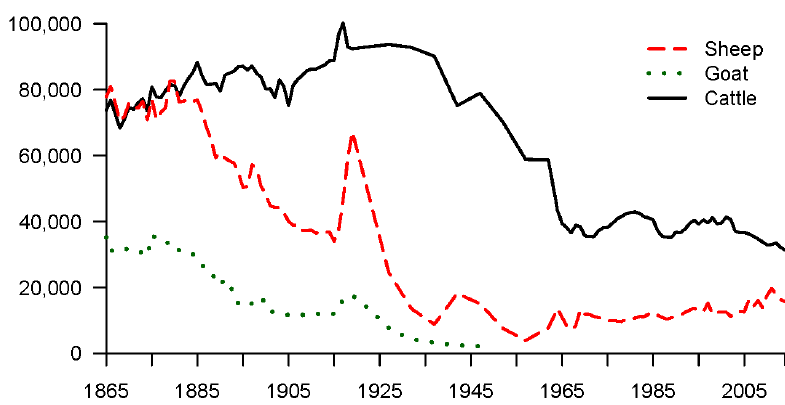
Figure 9. Illustration of the change in number of cattle, sheep and goats in Dalarna, from 1865 until 2014. From 1947 onward there are no records on the number of goats. Solid black line represents cattle, red dashed line represent sheep and green dotted line represents goats. Sources: Regional Agricultural Societies and Statistics Sweden.